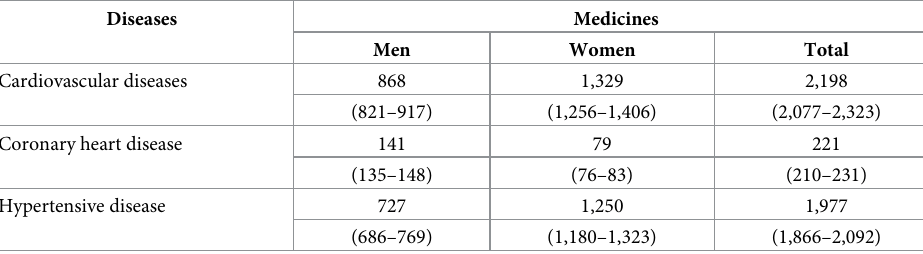
Table 5. Estimated costs (thousand USD $) of medications by CVD and gender for CCSS due to excessive salt intake in Costa Rica, 2018 (95% uncertainty intervals).